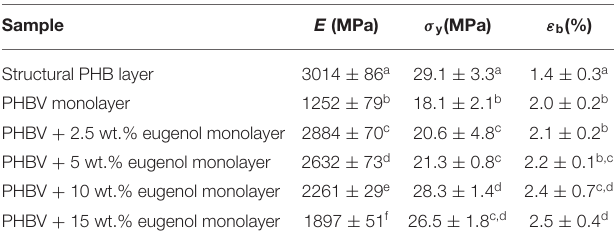
TABLE 4 | Mechanical properties of the cast-extruded poly(3-hydroxybutyrate) (PHB) sheet and electrospun monolayer films